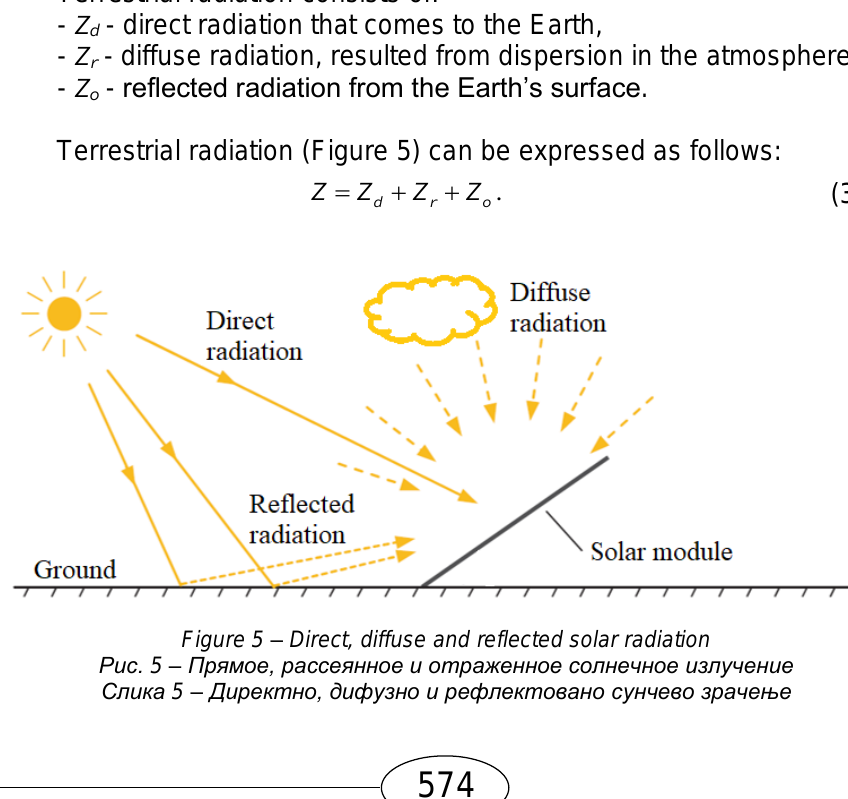
Figure 4 – Energy storing principle (Renewable Energy World, 2003) Рис. 4 – Принцип накопления энергии (Renewable Energy World, 2003) Слика 4 – Принцип складиштења енергије (Renewable Energy World, 2003)